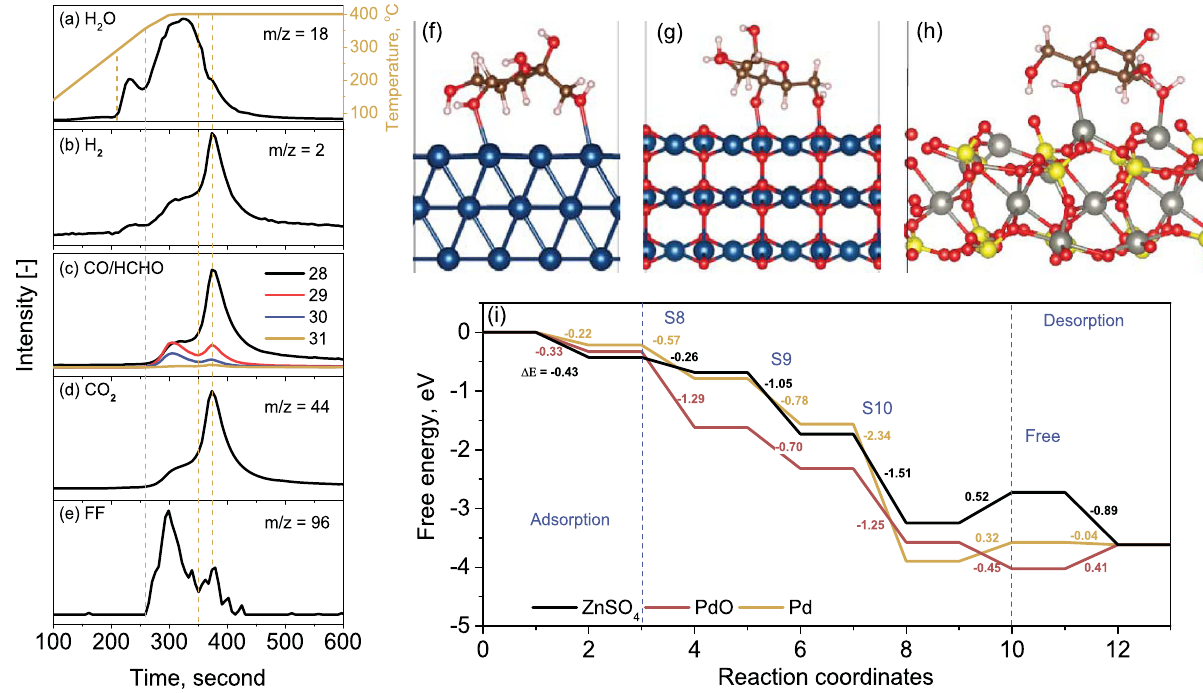
Fig. 8 | TGA-MS pro fi les of the principal products from and DFT calculation results for the pyrolysis of glucose. Panels a – e for the TGA-MS spectra of the products obtained from pyrolysis of glucose, including H 2 O ( a ), H 2 ( b ), CO and HCHO( c ),CO 2 ( d )andfurfural(FF)( e ).Panels f – h fortheoptimizedgeometriesfor